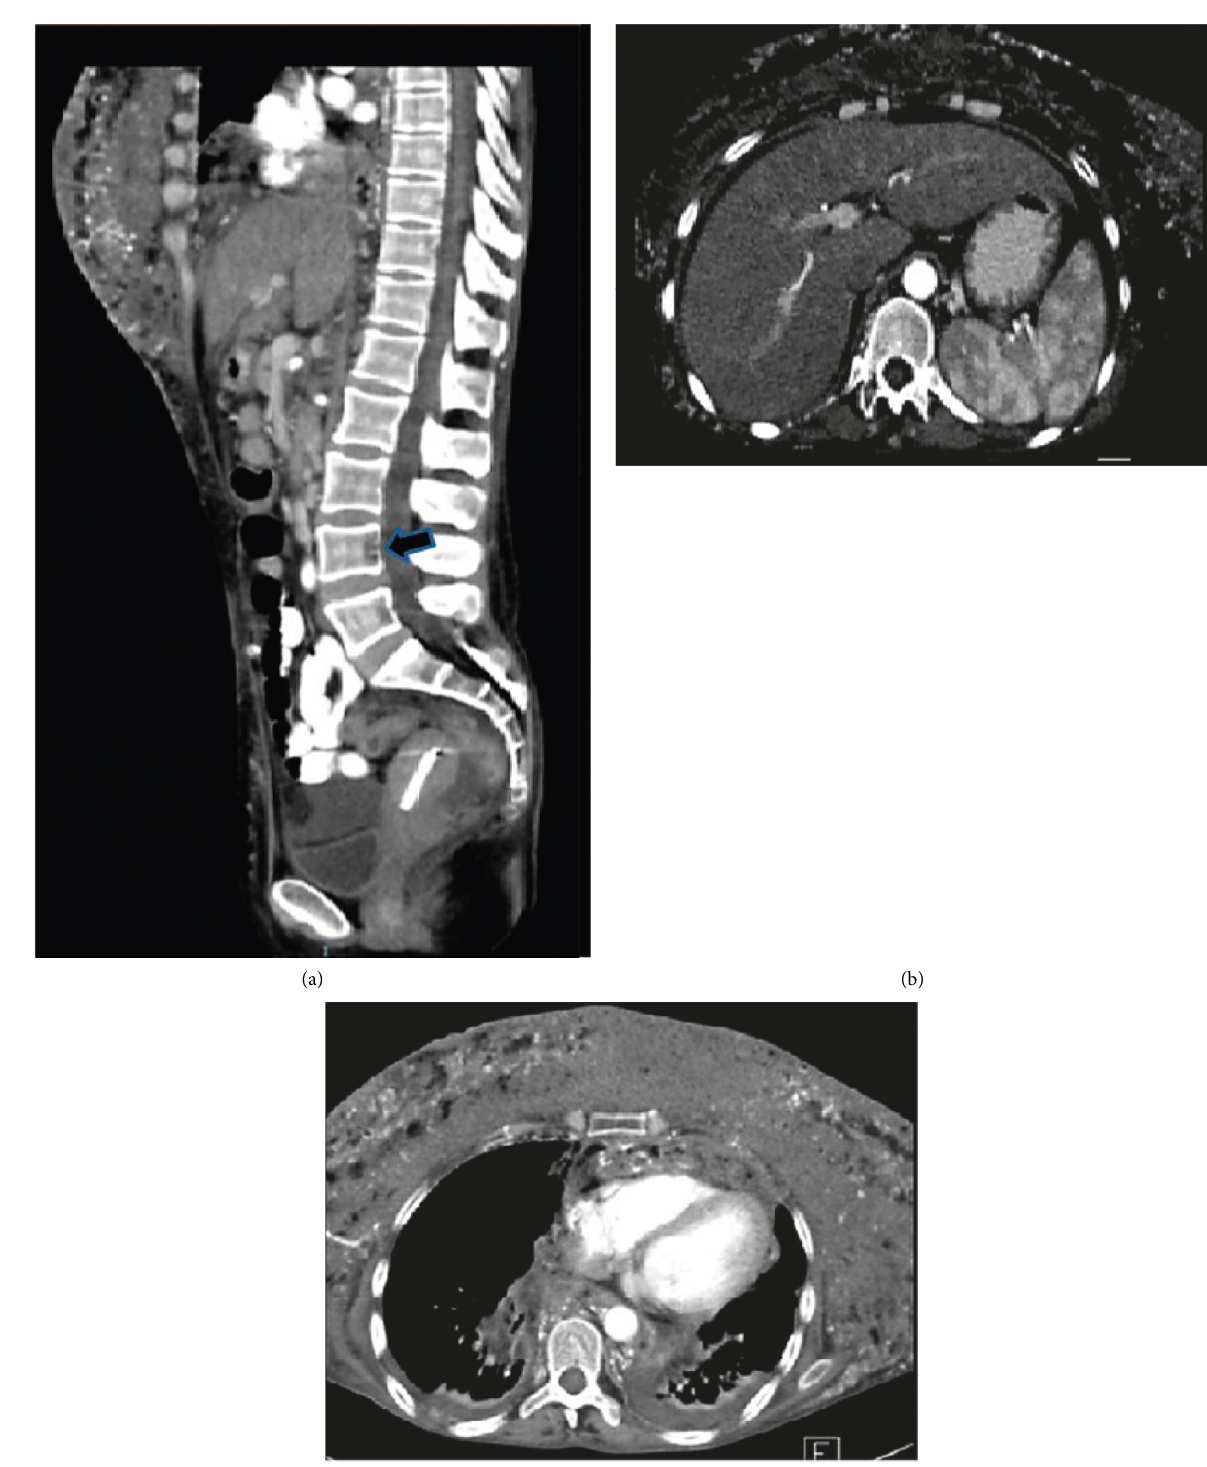
Figure 1: Computed axial tomography (contrast phase). (a) Sagittal section shows an increase in soft tissue volume in the mammary region of the L4 vertebral body. A hypodense lesion with continuity loss is seen at the posterior vertebra wall suggestive of erosive injury (arrow). (b) Cross section at the abdomen shows the spleen with granular characteristics and heterogeneity of its content. (c) In the thorax, abundant granular tissue is observed not only at the rib cage but also in the anterior and posterior mediastinum, secondary to the substance dissemination and